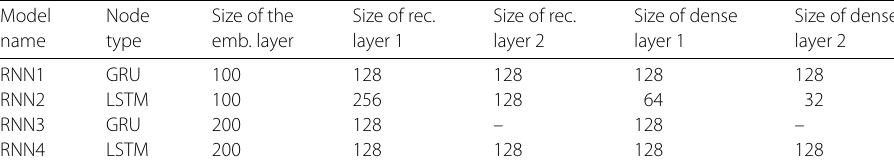
Table 15 Detailed composition (number of neurons) of the Recurrent Neural Networks Model